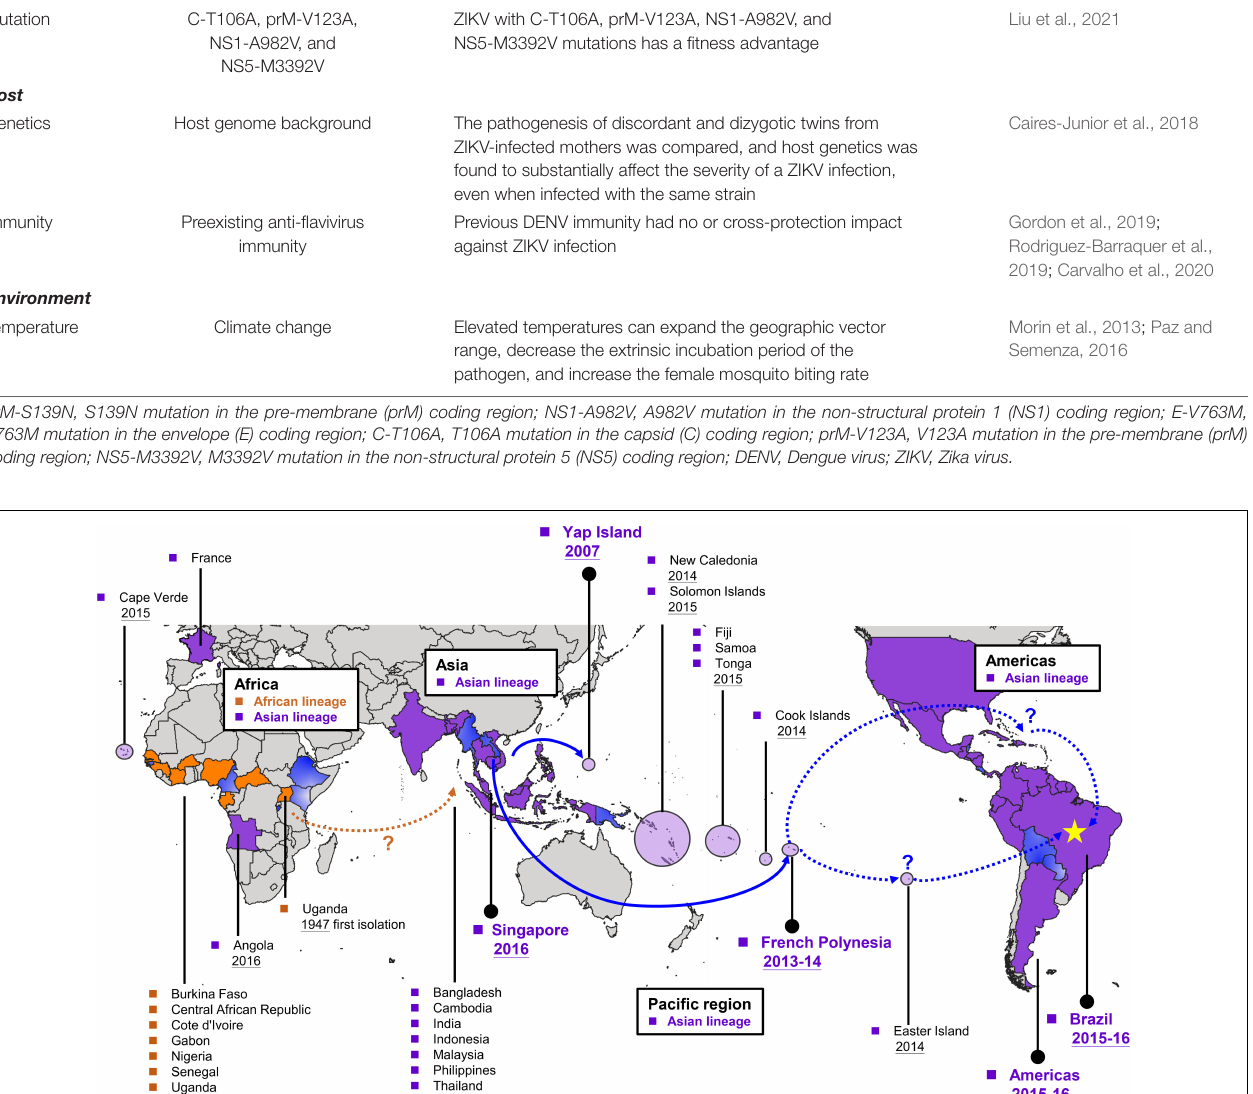
Frontiers in Microbiology |